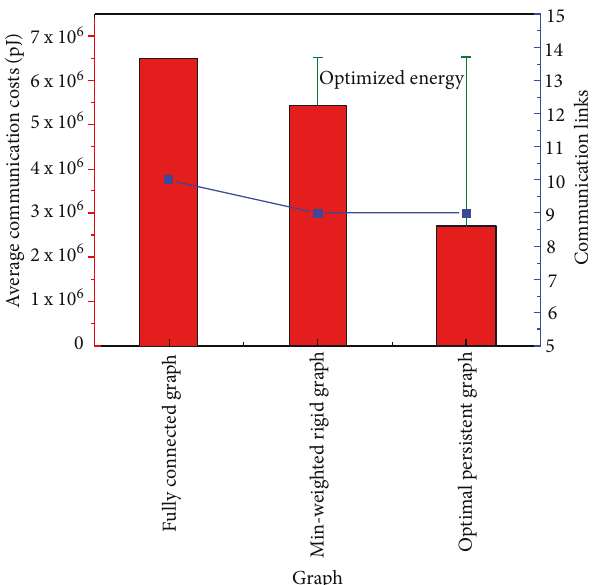
Figure 22: Average communication costs and links in di ff erent graphs.